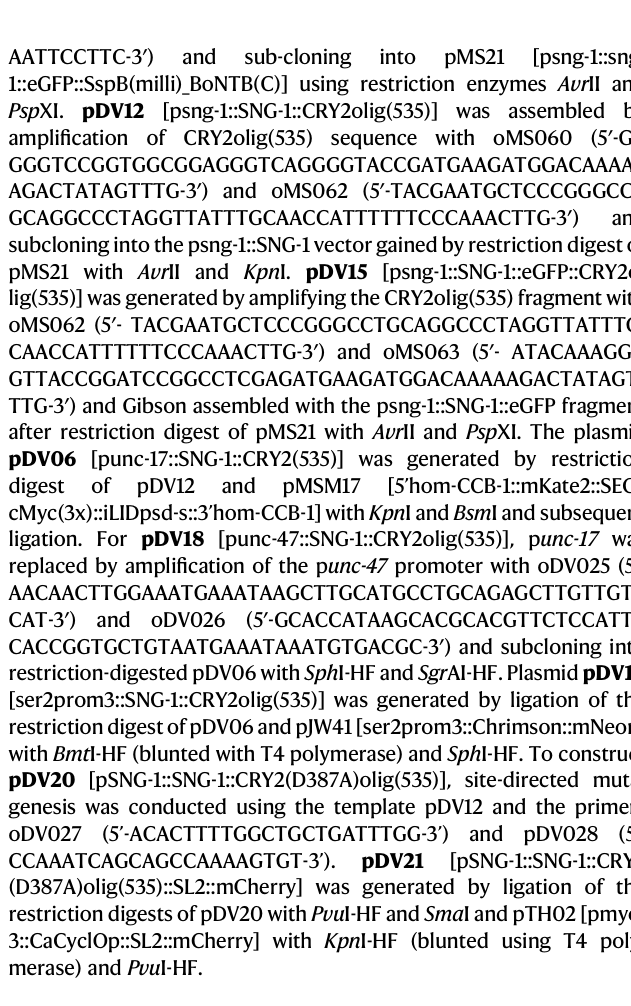
Fig.9|Comparisonoftoolsforoptogeneticsilencingofsynaptictransmission. a Matrix showing time constants (activity on- and offset) of optogenetic tools for synaptic inhibition. Tools are grouped by their molecular nature/mechanism of action. Data was derived from refs. 13,18,19,22 – 24,27,28,30,38,82,83 b ACR2 expressed in C. elegans cholinergic motor neurons evokes rapid and complete